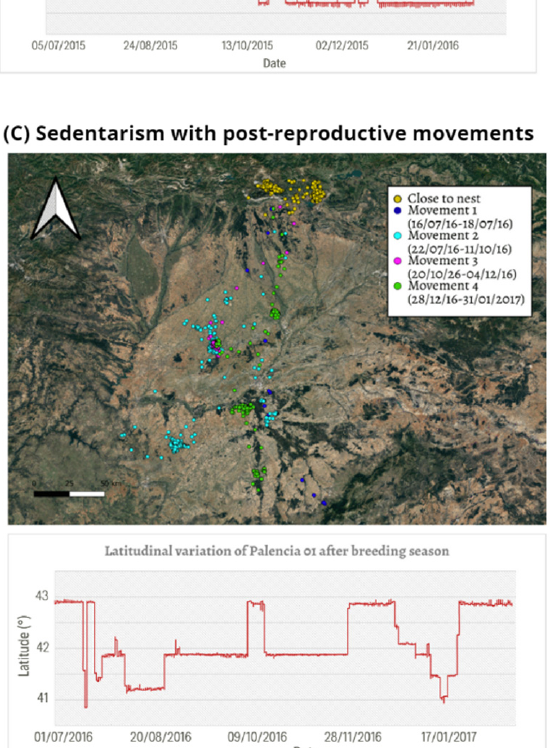
Table 1. Movement parameters (maximum distance to nest, mean distance to nest, and daily trav- eled distance) broken down by strategies (sedentarism, sedentary with post-reproductive move- ments, and migration). The sample unit was the post-reproductive period (n = 136), so one individ- ual with several years can be found in different strategies. Values are expressed as mean ± standard deviation (minimum-maximum). Number of Post-Repro- ductive Peri- ods (%) Maximum Latitudinal Variation from the Nest (°) Nights outside Breeding Area Maximum Distance to Nest (km)